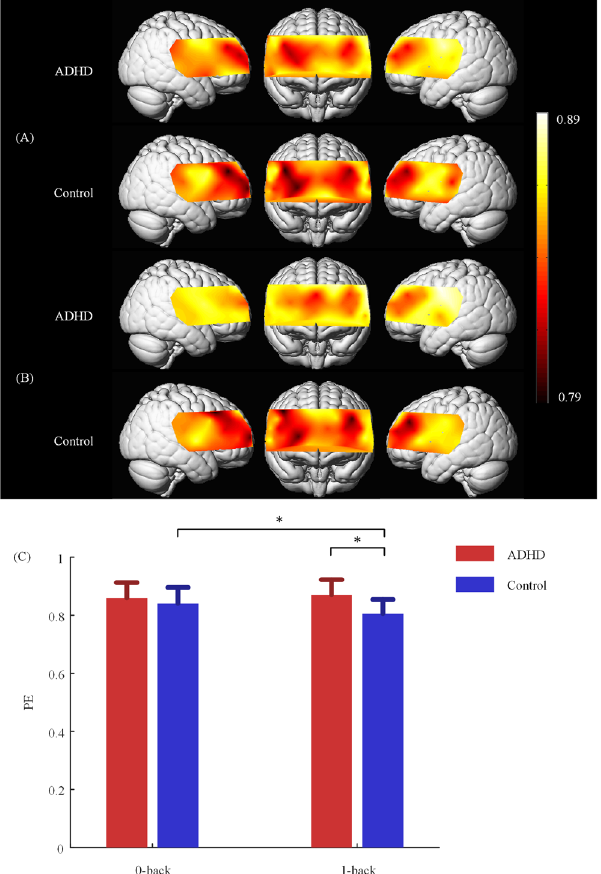
Figure 2. PE maps for the 0-back condition ( A ) and 1-back condition ( B ). The PE values are indicated by color. The light colors represent large PE values (high complexity), and vice versa. Bar plots of PE values showing the PE values of channel 3 in each conditions for the ADHD and control group ( C ). Error bars represent the standard error of the mean. * p <